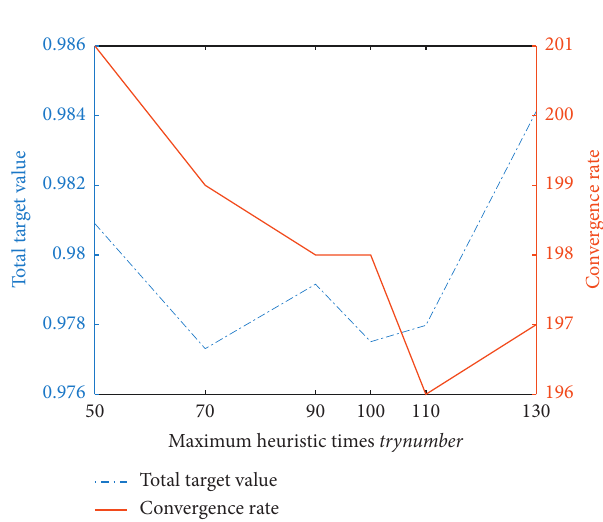
Figure 3: Adjustment of the parameter trynumber